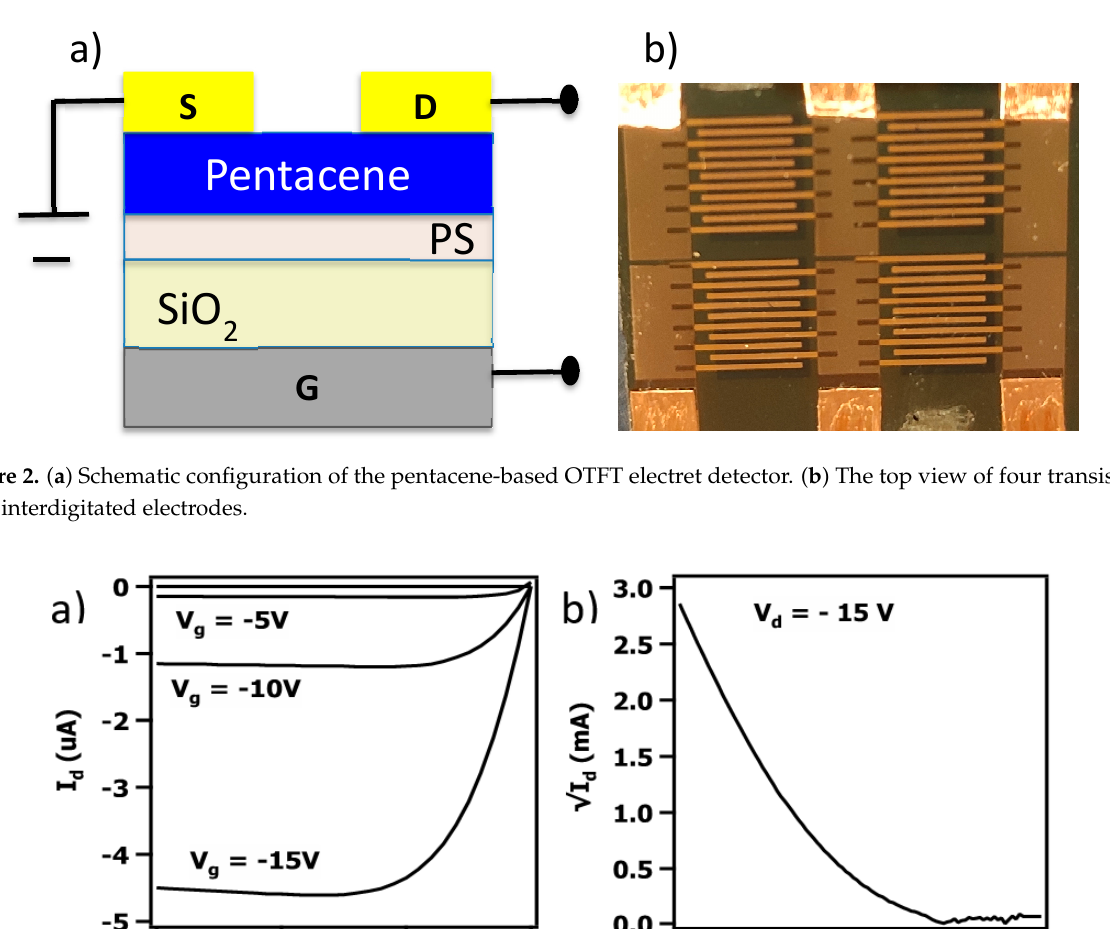
Figure 2. ( a ) Schematic configuration of the pentacene-based OTFT electret detector. ( b ) The top view of four transistors with interdigitated electrodes.